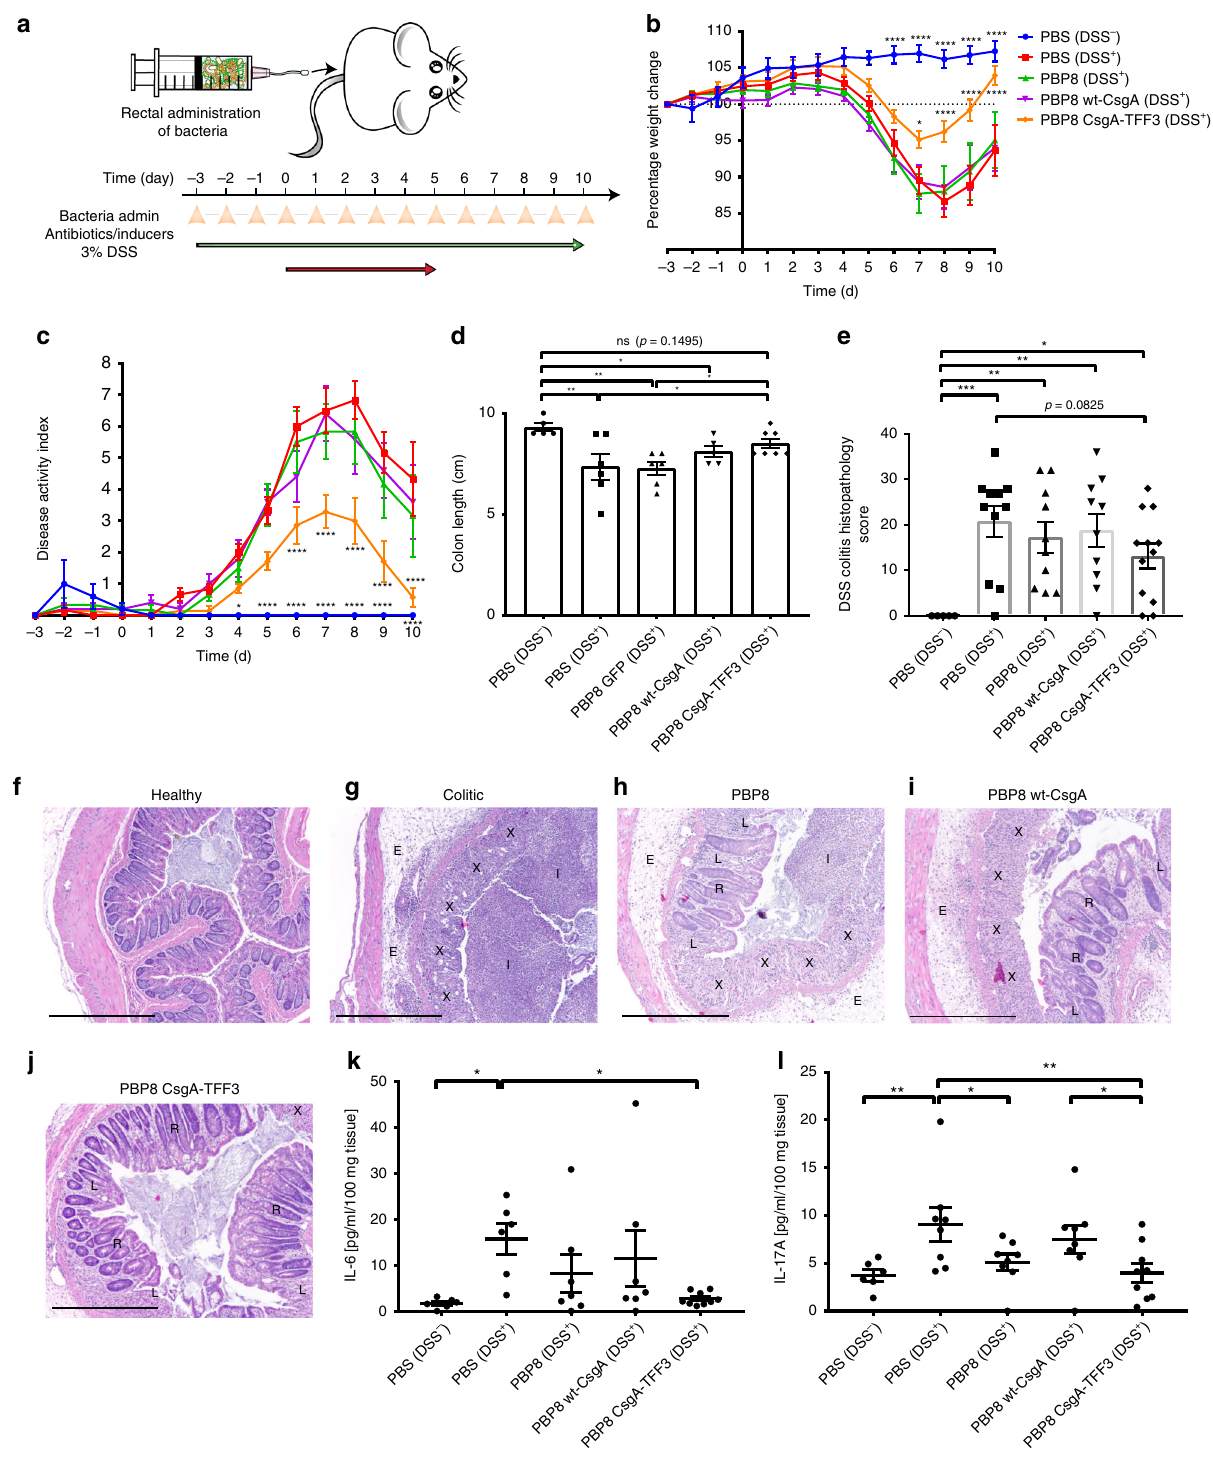
characterizing the barrier-enhancing function of CsgA-TFF3 led to similarly inconclusive results when compared to wt-CsgA (Supplementary Fig. 9). Although the effects of TFF3 fusion to CsgA on its interaction with host receptors is not clear from this work, it is possible that both domains could contribute to modulating local gene expression. Matrix metalloproteinase-9 (MMP-9), whose function is to breakdown extracellular matrix proteins in in fl ammatory envir- onments, is upregulated during IBD and is an essential mediator